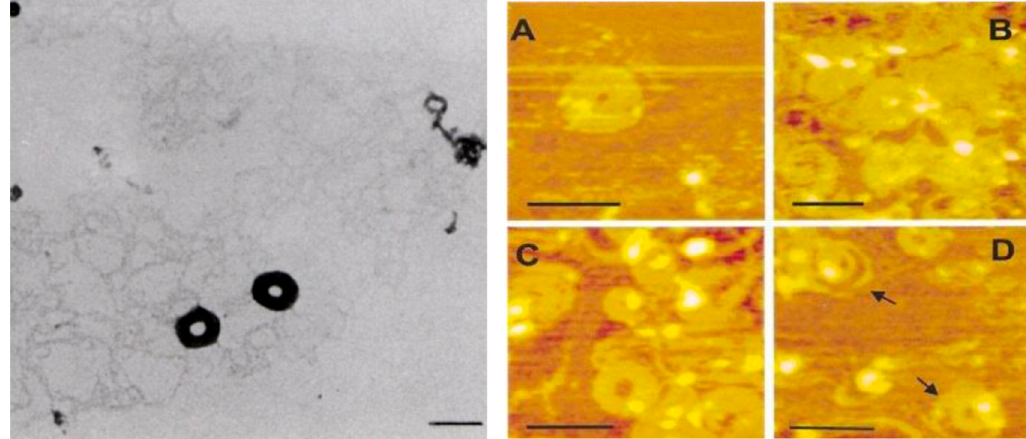
Figure 1. Electron micrograph of DNA treated with 200 µ M of spermidine (Left). Scale bar is 100 nm. Scanning force microscopy images showing the toroid structures of pGL3 plasmid DNA formed by incubation with polyamines (Right). ( A ) 25 µ M spermine; ( B ) 5 µ M of pentamine (3-3-3-3, H 2 N(CH 2 ) 3 NH(CH 2 ) 3 NH(CH 2 ) 3 NH(CH 2 ) 3 NH 2 ); ( C ) 2 µ M of hexamine (3-4-3-4-3, H 2 N(CH 2 ) 3 NH(CH 2 ) 4 NH(CH 2 ) 3 NH(CH 2 ) 4 NH 2 (CH 2 ) 3 NH 2 ). The numbering system in these synthetic polyamines is the number of –CH 2 - groups between amino and imino groups. ( D ) Scale bar is 200 nm. Adapted with permission from Reference [41].